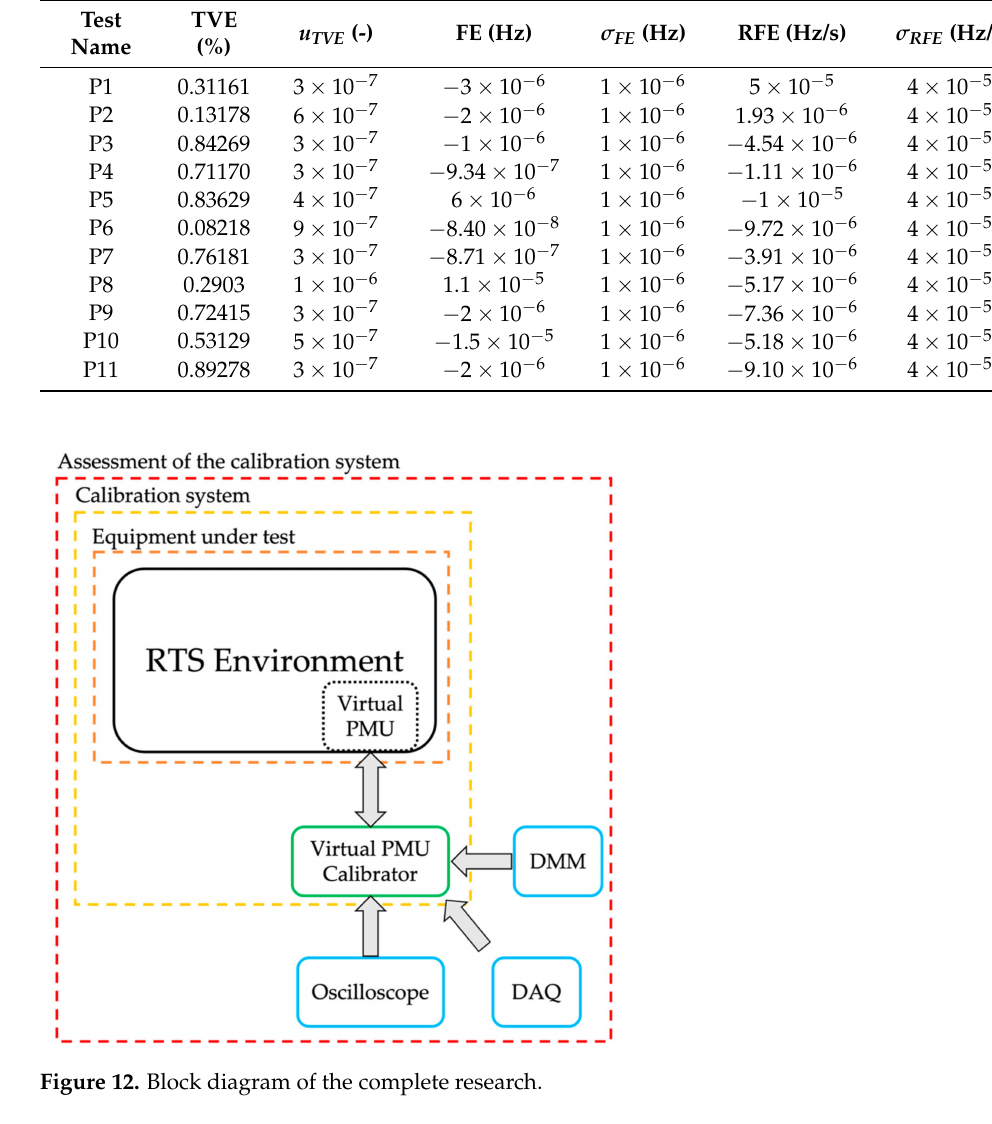
Figure 11. THD obtained in each harmonic test from H1 to H16. Table 22. Measurement results of the phase tests.